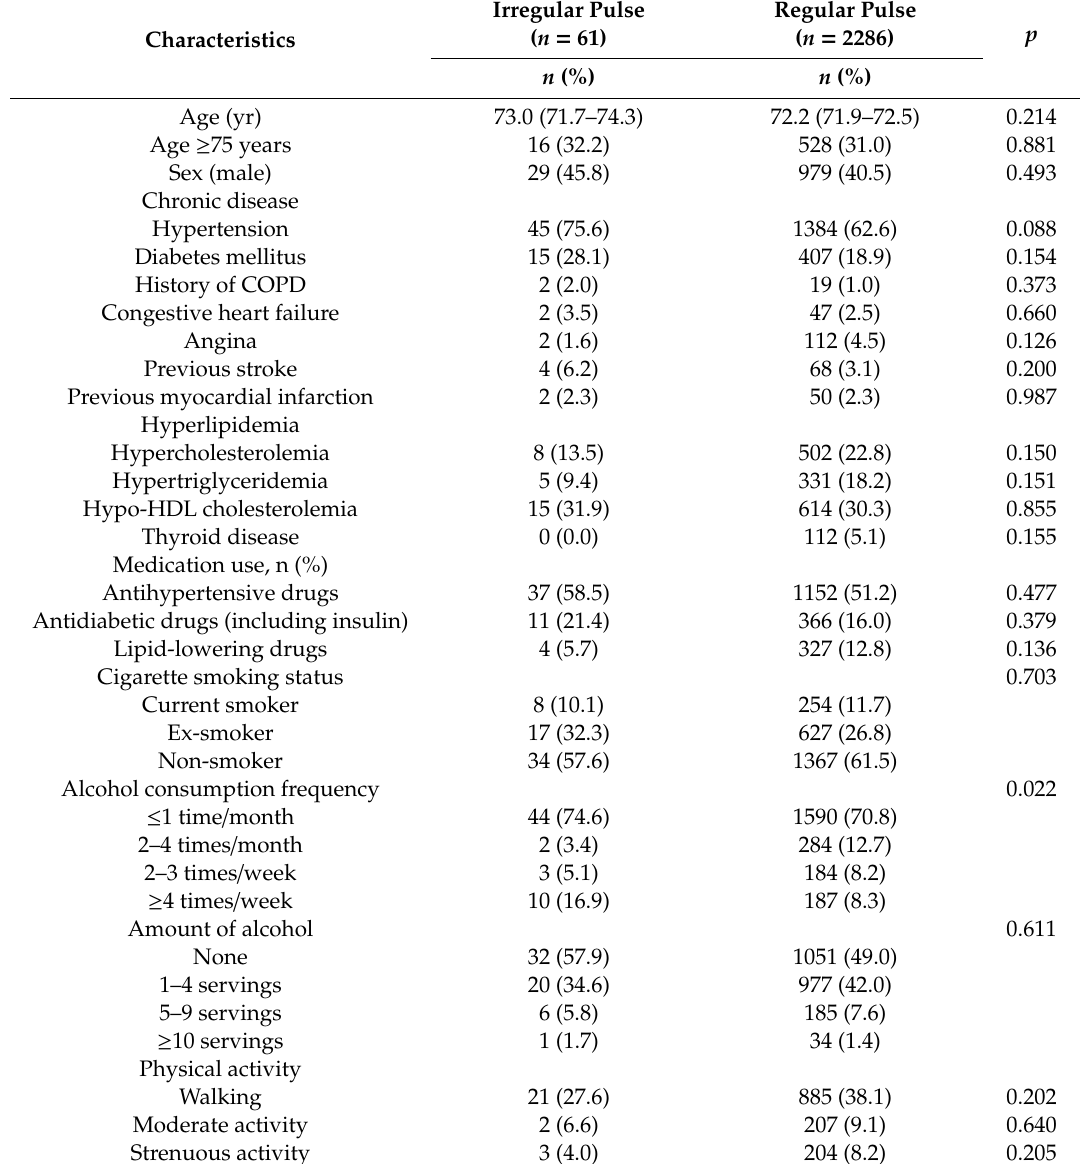
Table 1. General